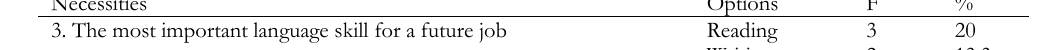
TABLE 3. S tudents’ perceptions of the importance of the four language skills for their future work domain.